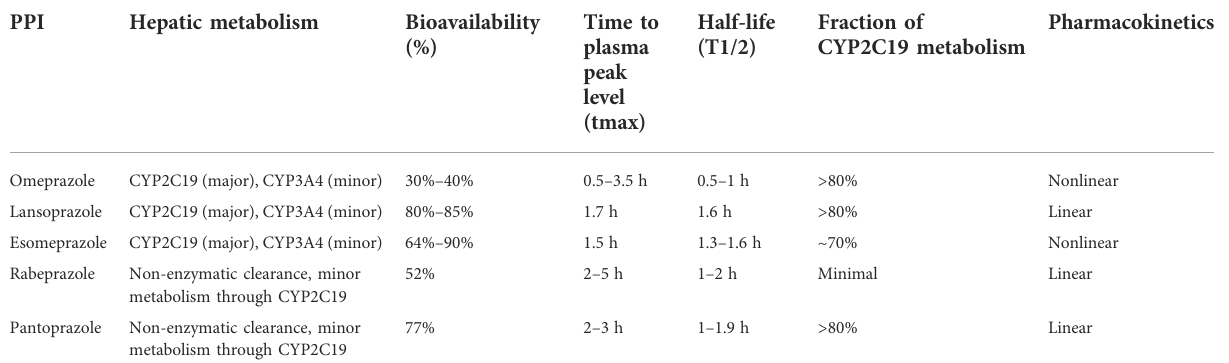
TABLE 1 Pharmacokinetic properties of proton pump